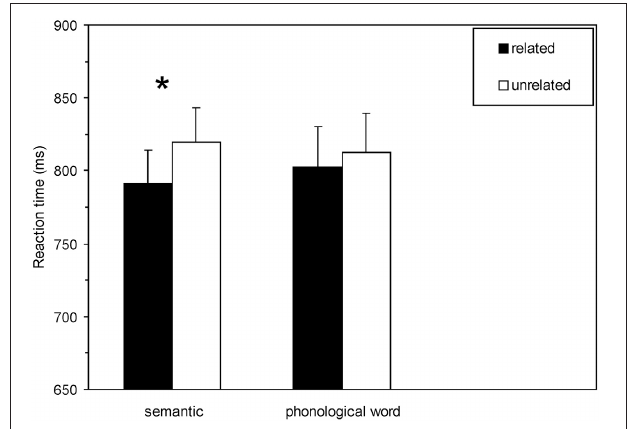
FIGURE 2 | Experiment 1. Mean lexical decision latencies ( n = 22) as a function of semantic relatedness and induction task. In this and the following figures, the vertical lines depict the standard error of the means of each condition, and the asterisk indicates significant masked semantic priming effects within each induction task. Related = semantically related prime target pairs; unrelated = semantically unrelated prime target pairs. The asterisk indicates significant priming effects ( p < 0 .